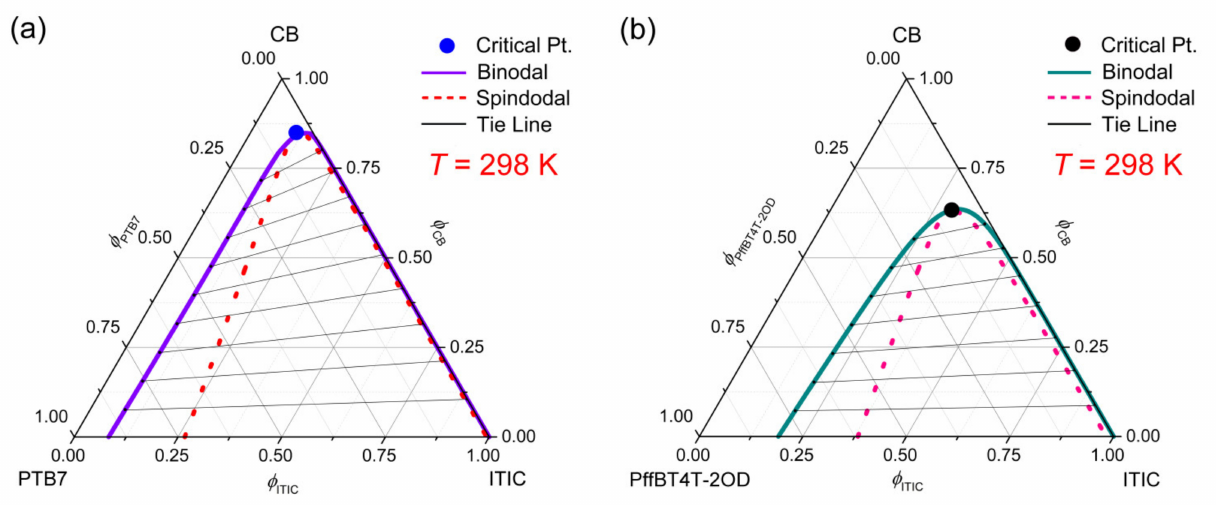
Figure 8. Phase diagrams for the ternary systems at constant T = 298 K. ( a ) CB/PTB7/ITIC: χ 12 = 0.42, χ 13 = 1.25, χ 23 = 1.88, s = 0.001267 and r = 0.088029. ( b ) CB/PffBT4T-2OD/ITIC: χ 12 = 0.34, χ 13 = 1.25, χ 23 = 1.33, s = 0.002448 and r =